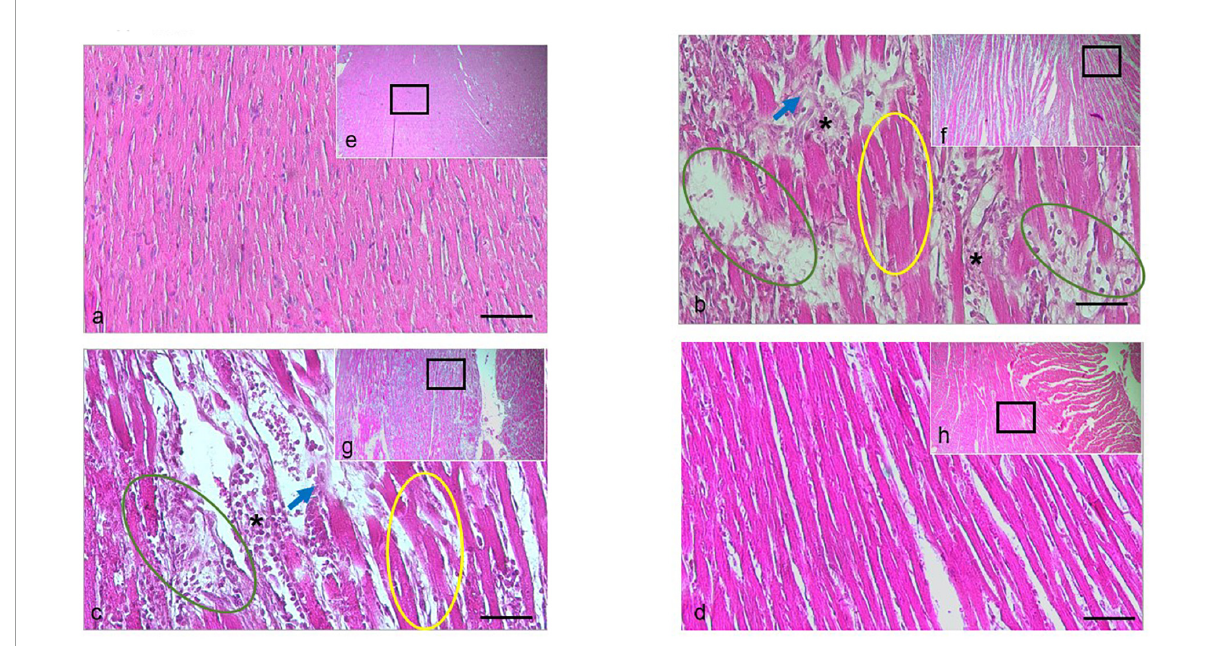
FIGURE5 H&E staining of the cardiac tissue isolated from the rat in the normal group, or treated with Iso ± AGNO 3 or AgNPs. (a-d) were presented as 200 × magnification and representative images from (e–g) (black rectangle) were 40 × magnification. Scale bar = 100 µ m. Yellow circle shows myofibril waviness, green circle shows interstitial edema, asterisk indicates eosinophil infiltration, and blue arrow points to necrotic cardiomyocytes. The (a,e) normal, (b,f) Iso-treated, (c,g) Iso + AgNO 3 -treated, and (d,h) Iso + AgNPs-treated rat